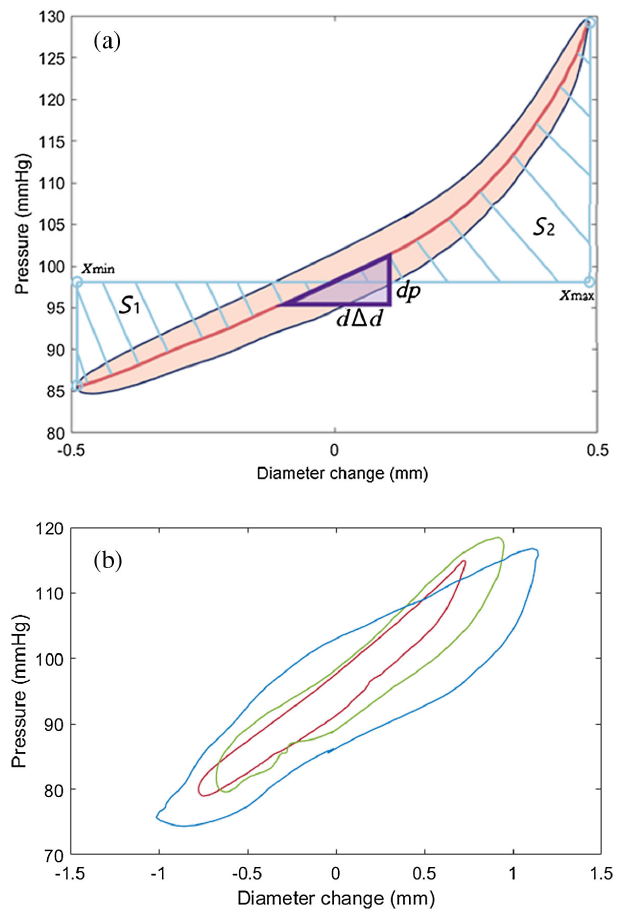
FIG. 5. Hysteresis loop of the pressure-diameter change: (a) donor IX at 63 bpm in the vertical direction at mid-length of the aortic segment. Area inside the loop is proportional to the energy loss. The average of areas S 1 and S 2 , found using the middle line of the loop (red line) and the horizontal line passing through it at x ¼ 0 , is proportional to the storage energy. The triangle (violet line) describes the storage modulus computed as the slope at the origin ( dp=d Δ d ); (b) donor XI hysteresis loop obtained from the cyclic change of aortic diameter and inlet pressure measured in horizontal direction:, red line 60 bpm; green line 100 bpm; blue line, 170